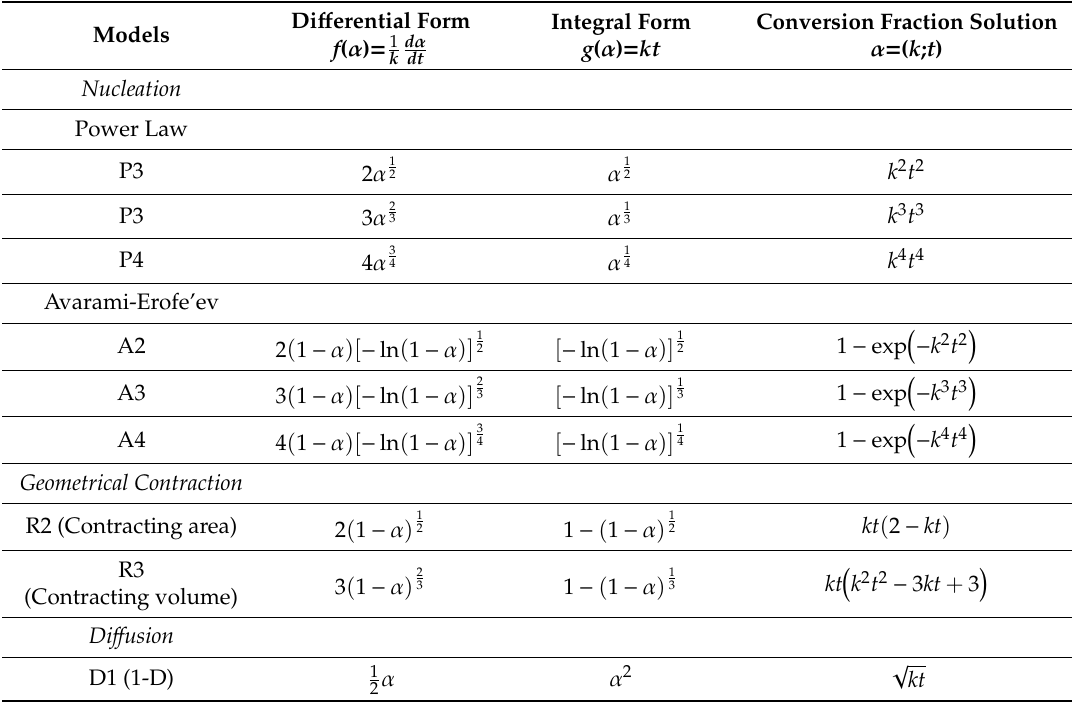
Table 1. Set of the various solid-state reaction models, which can potentially describe thermal transformations in solids. Solid-state reaction rates are presented in their di ff erential and integral forms as well as the corresponding analytical expressions of the conversion